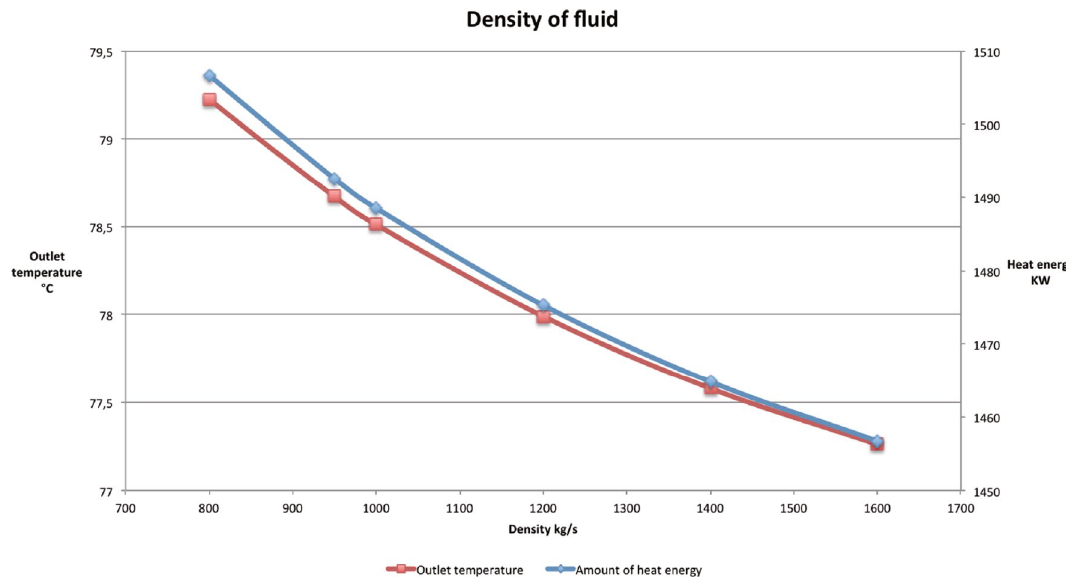
Fig. 2 Temperature and heat energy regarding working fluids’ densities